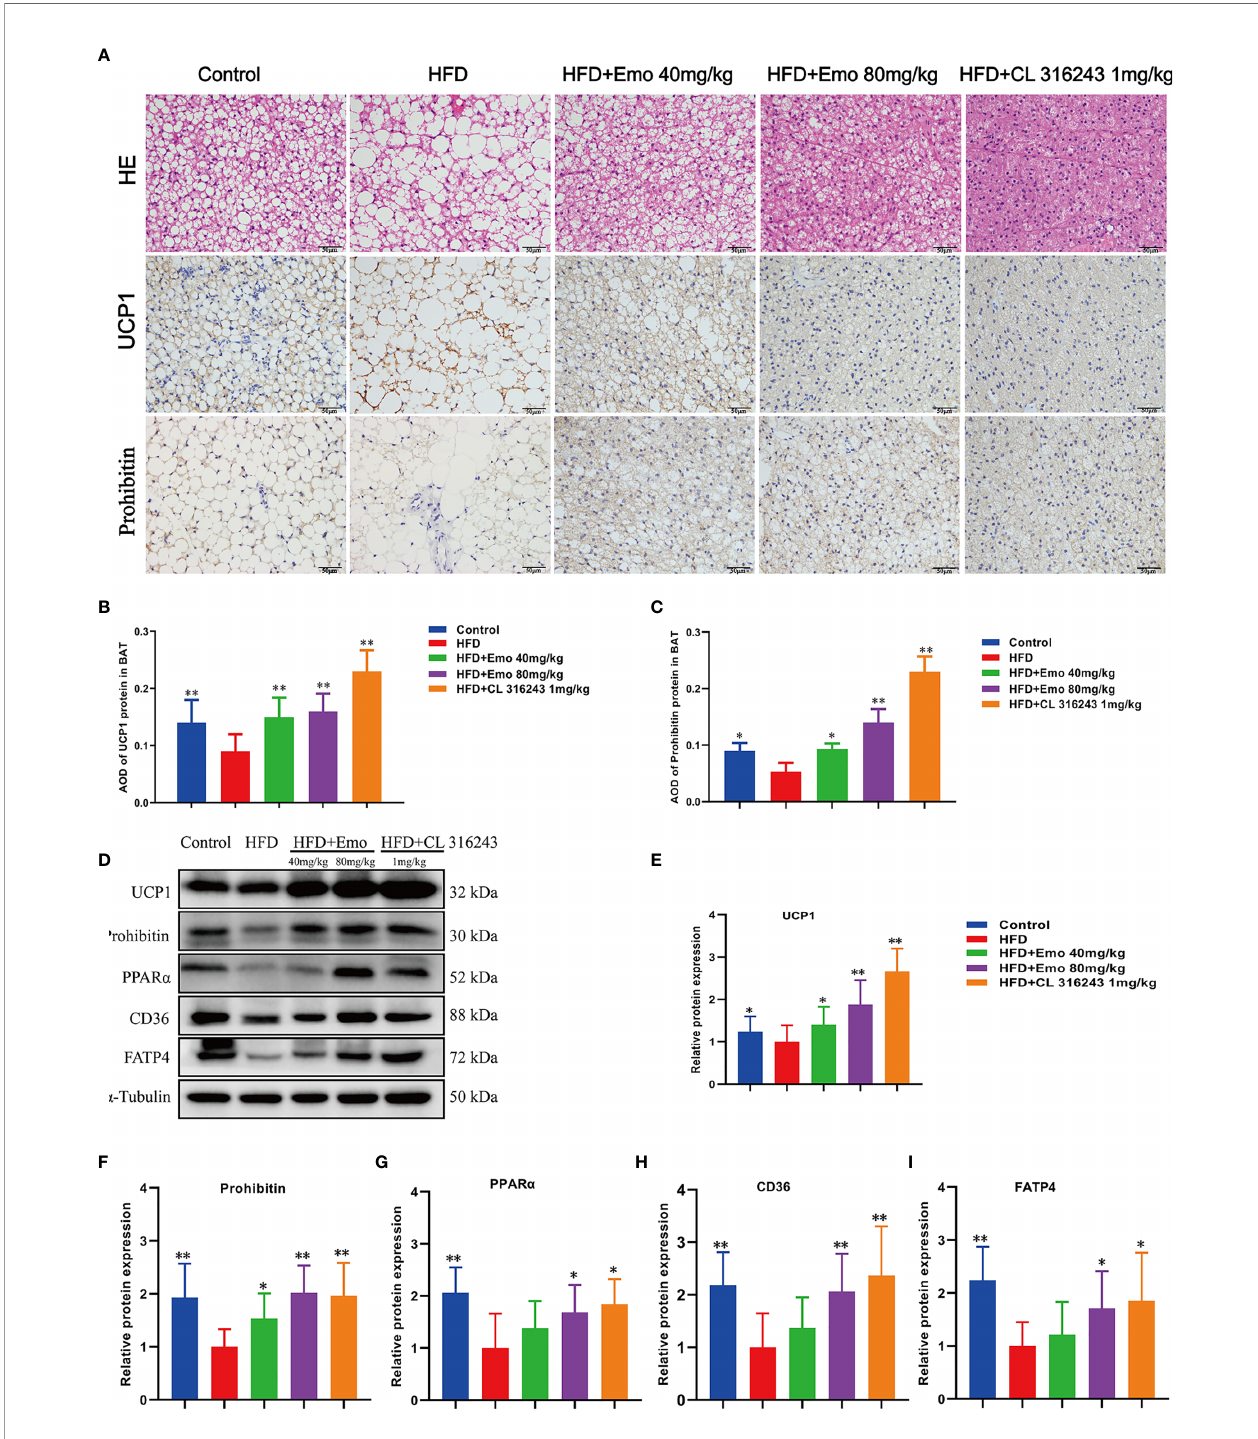
FIGURE 4 | Effects of emodin on the morphology and function of BAT in HFD mice. (A) H&E and immunohistochemical staining of BAT. (B) Relative expression of UCP1 in BAT. (C) Relative expression of prohibitin in BAT. (D) Protein expression of UCP1, prohibitin, PPAR a , CD36 and FATP4 in BAT using western blotting. (E) Protein expression of UCP1. (F) Protein expression of prohibitin. (G) Protein expression of PPAR a . (H) Protein expression of CD36. (I) Protein expression of FATP4. HFD, high fat diet; Emo, emodin. Data are expressed as mean ± SE. * P < 0.05, ** P < 0.01 vs. HFD